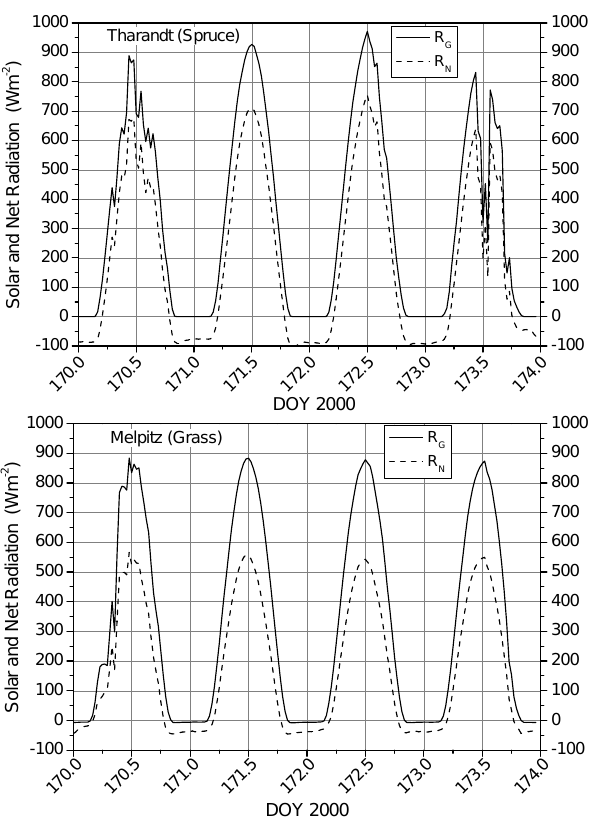
Fig. 6. Air and canopy temperature and saturation deficit (vpd) at the Anchor Station Tharandt (spruce, minor water limitation, panel above) and at the Melpitz experimental site (short grass, strong wa- ter limitation, panel below) used for calculation of omega during the investigation period 18 to 21 June 2000.